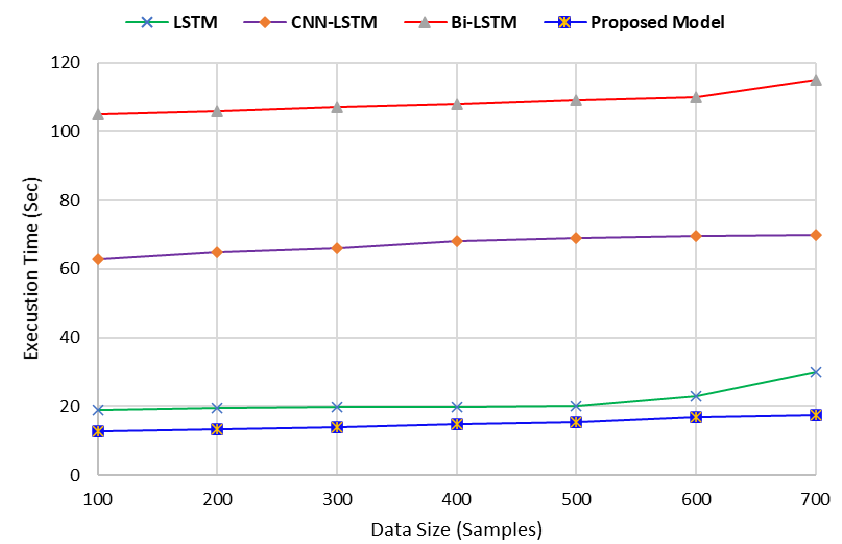
Figure 10. Scalability analysis of our model with other state-of-the-art models.